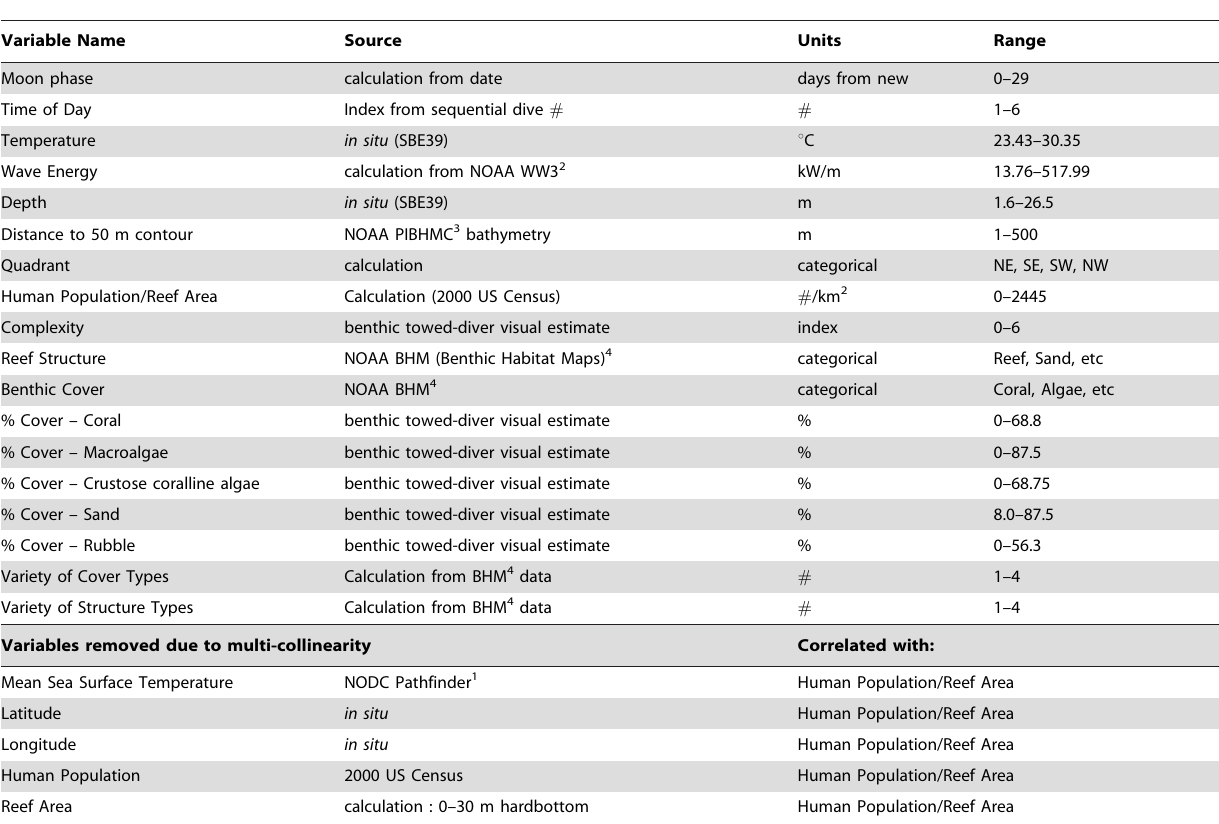
Table 1. Environmental predictor variables included in the boosted regression tree